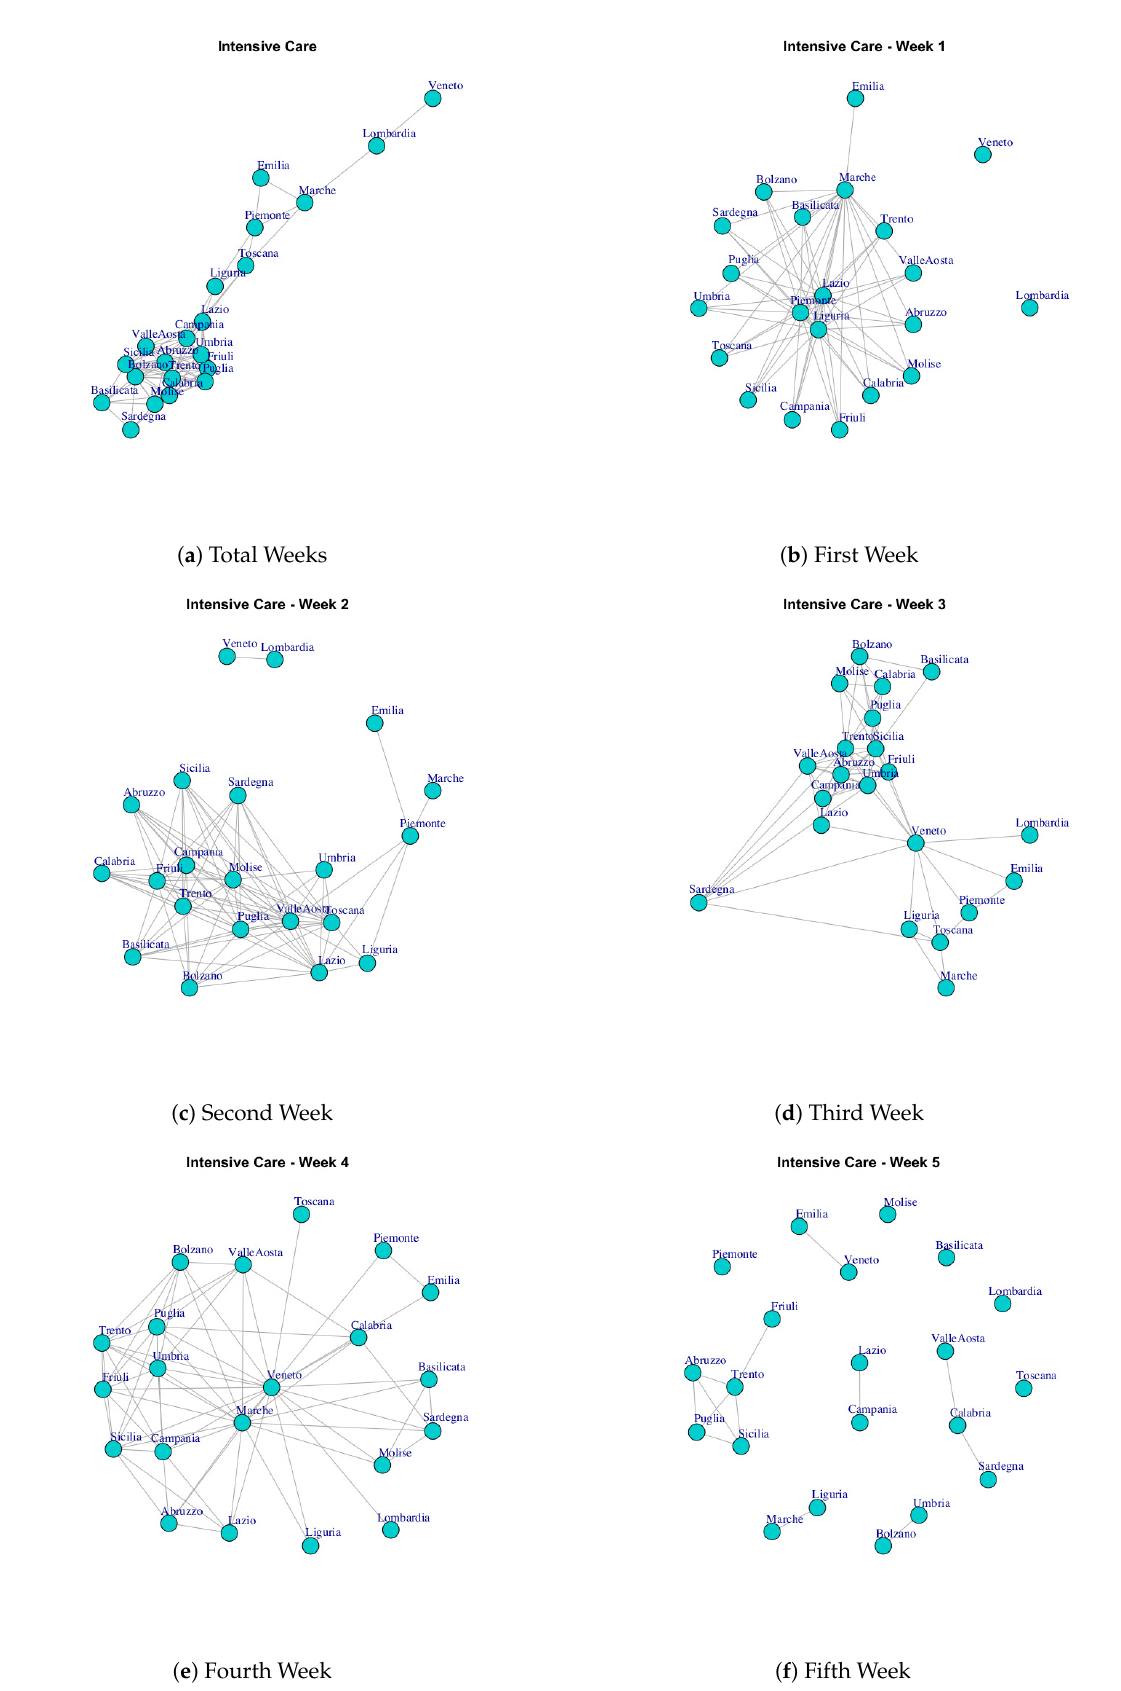
Figure 4. Evolution of Intensive Care